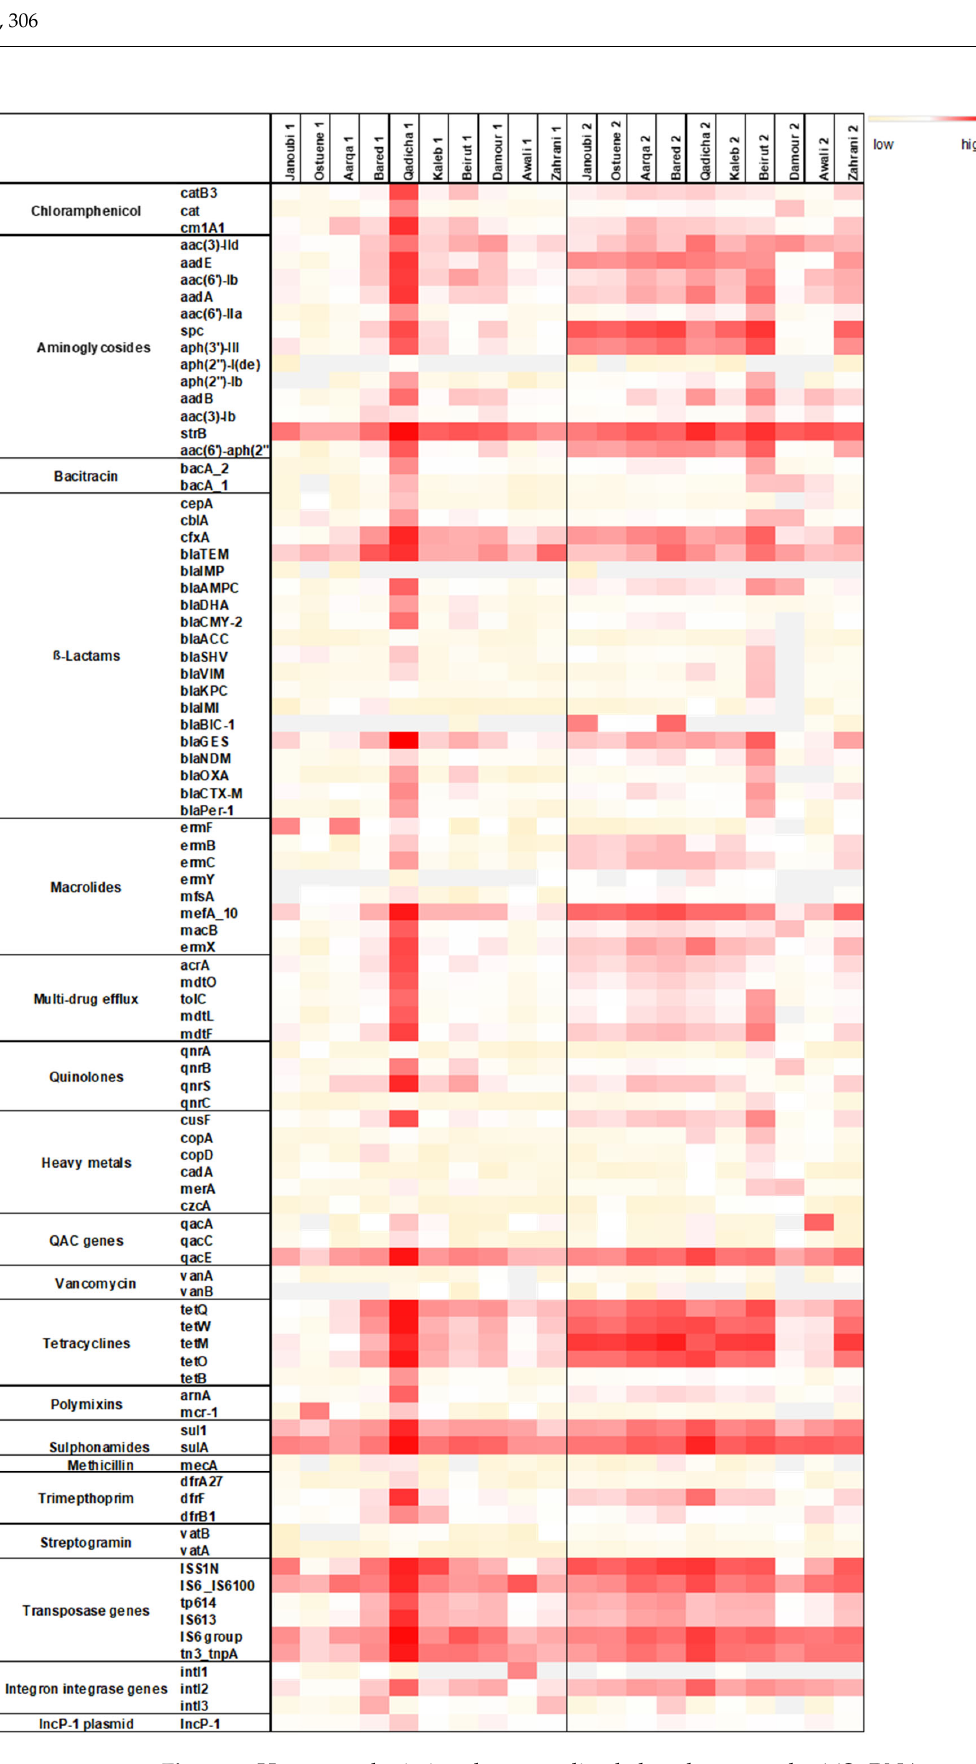
Figure 1. Heat map depicting the normalized abundances to the 16S rRNA gene of each targeted gene in spring (1) and in winter (2) in the 10 estuarine Lebanese river samples. Three-color